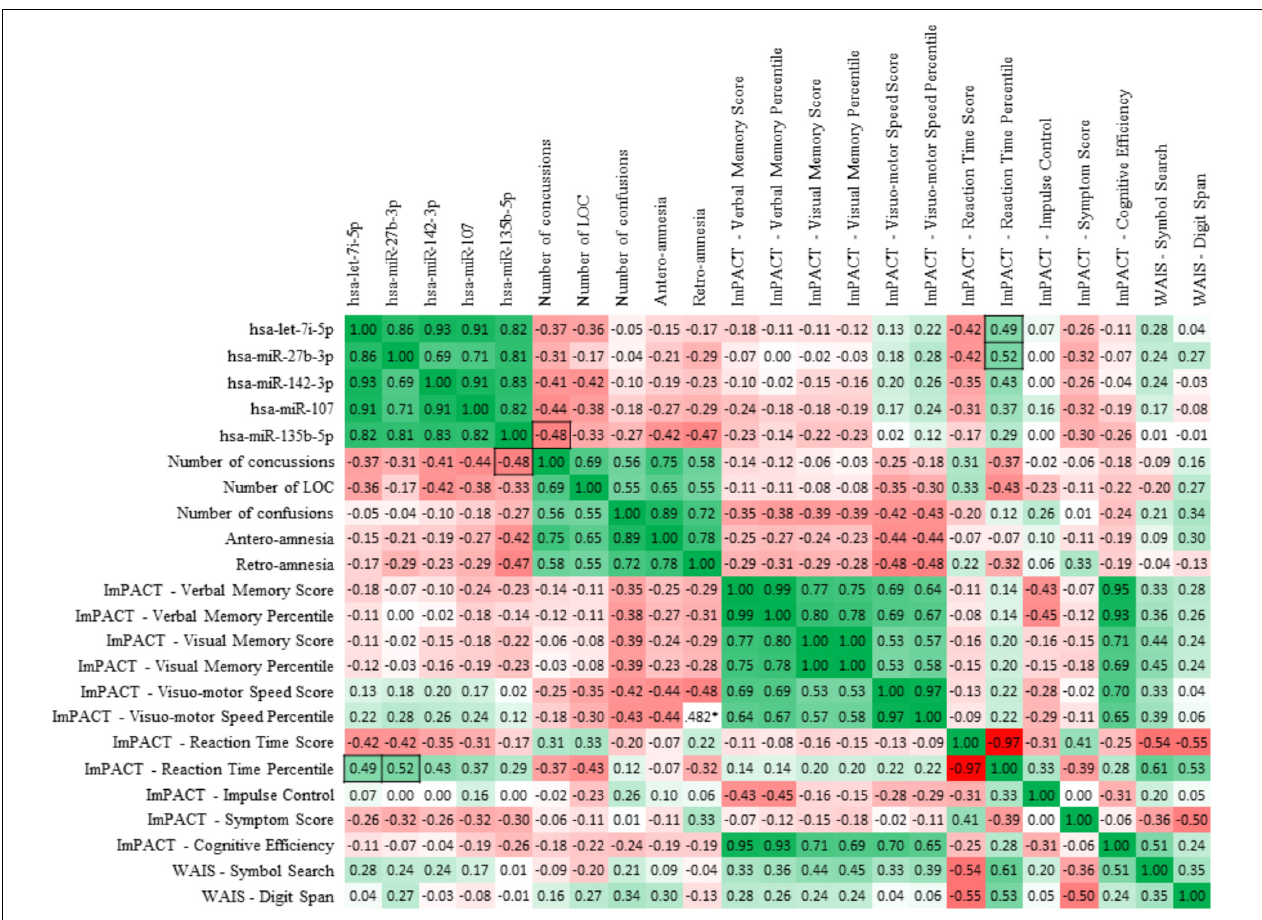
FIGURE 7 | Sperman correlation of the 5 candidate miRNA biomarkers with neurocognitive assessment tools. Spearman R -values depict correlations between salivary concentrations of the 5 miRNAs of interest and the indexes of ImPACT test and WAIS symbol search and digit span results. Boxes highlight correlations between miRNA levels and clinical indexes which are statistically significant ( p < 0.05). Values highlighted with black borders show the statistically significant ( p < 0.05) correlations between miRNA levels and clinical